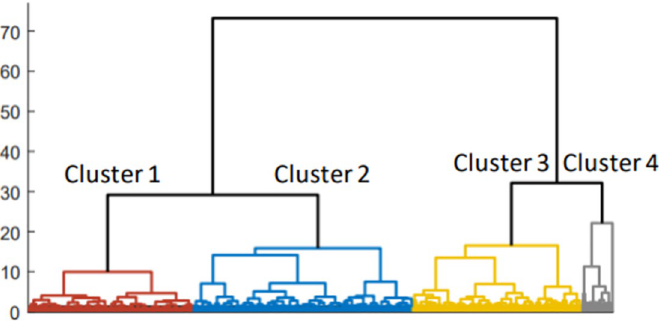
Fig 4. Clustering results employing the resultant vector-valued Wasserstein distance on TCGA data.